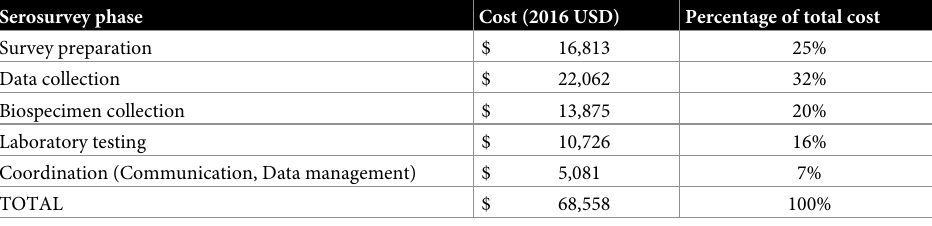
Table 1. Costs per phase of serosurvey implementation in Southern Province, Zambia.